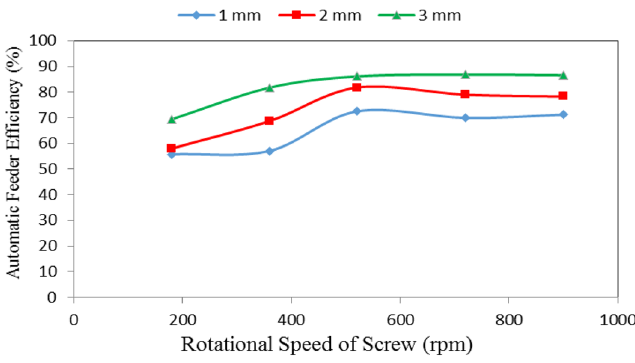
Figure 7. Automatic feeder efficiency at different feed pellet sizes and rotational speeds of